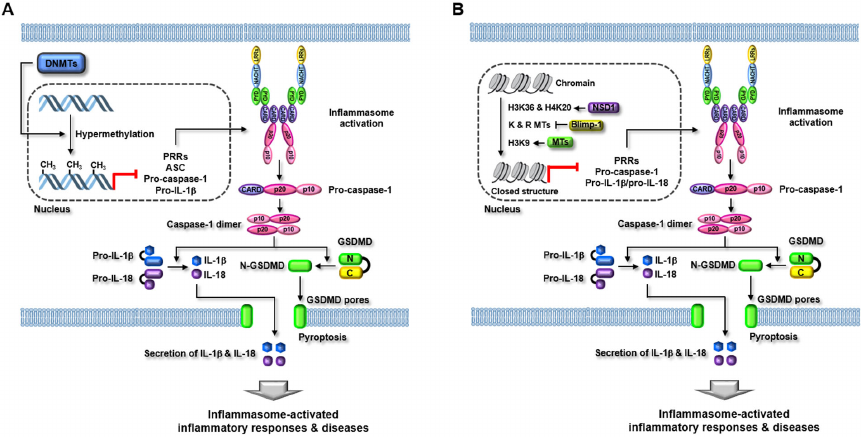
Figure 5. Regulatory role of MTs in inflammasome activation in inflammatory responses and diseases. ( A ) DNMTs induce hypermethylation in the promoter regions or genes of inflammasome components, such as PRRs, ASC, pro ‐ caspase ‐ 1, and pro ‐ inflammatory cytokines, and consequently inhibit the transcriptional expression of these genes and inflammasome activation. As a result, the caspase ‐ 1 ‐ mediated GSDMD pore formation and pro ‐ inflammatory cytokine secretion are sub ‐ sequently inhibited, resulting in the suppression of inflammasome ‐ activated inflammatory responses and diseases. ( B ) NSD1, Blimp ‐ 1, and histone MTs directly or indirectly induce the hypermethylation or hypomethylation of histone pro ‐ teins at lysine (K) and arginine (R) residues and close the chromatin structure, leading to the inhibition of the transcrip ‐ tional expression of inflammasome component genes and inflammasome activation. As a result, the caspase ‐ 1 ‐ mediated GSDMD pore formation and pro ‐ inflammatory cytokine secretion are subsequently suppressed, resulting in the amelio ‐ ration of inflammasome ‐ activated inflammatory responses and diseases. MTs, methyltransferases; DNMTs, DNA methyl ‐ transferases, ASC, apoptosis ‐ associated speck ‐ like protein containing a caspase recruitment domain; GSDMD, gasdermin D.